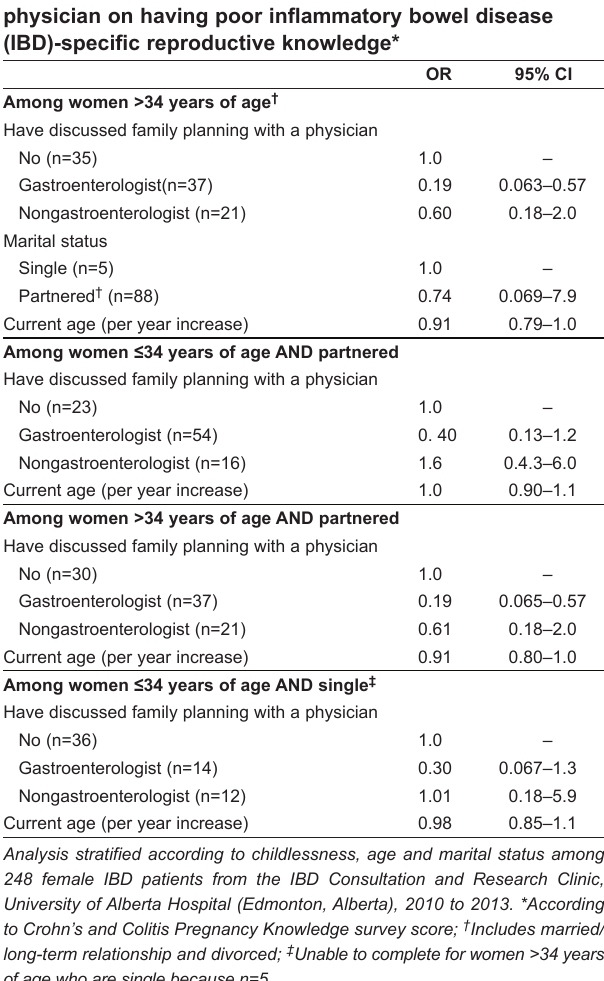
TABLE 5 Multivariable logistic regression model for estimating the effect of having discussed family planning with